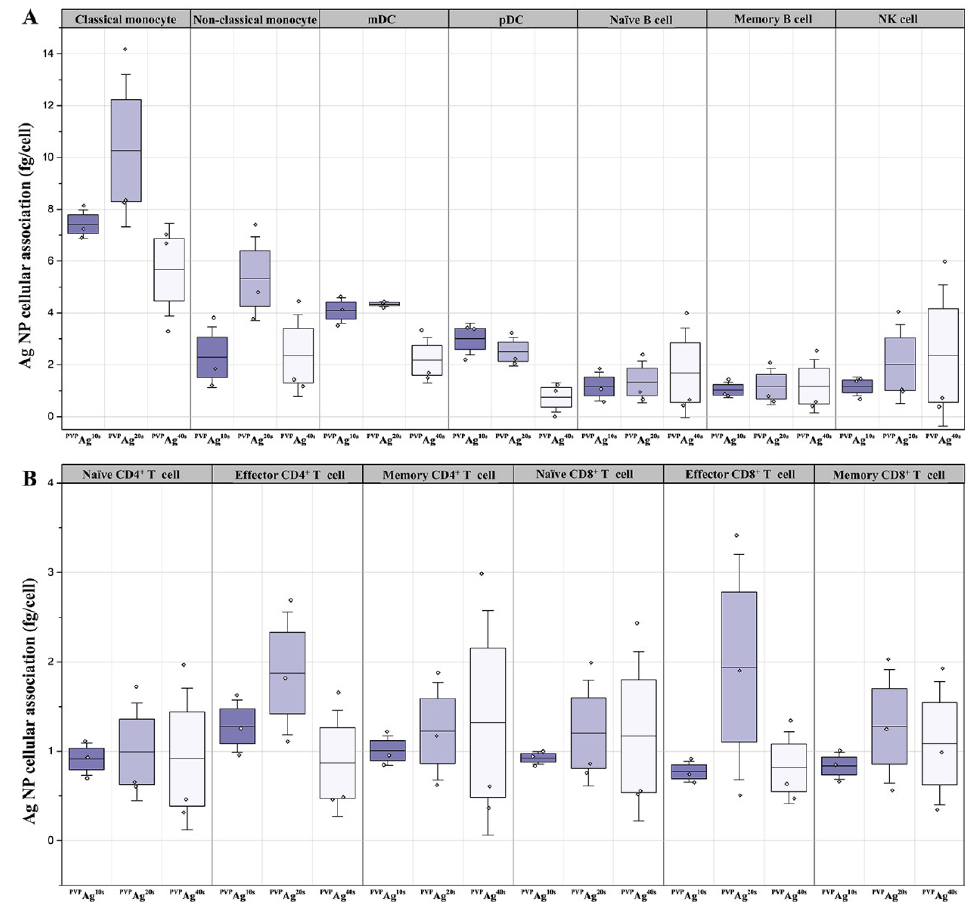
Figure 3. Cellular interaction of PVP Ag 10 , PVP Ag 20 , and PVP Ag 40 Ag NPS in hPBMC. ( A ) Comparison of the cellular association of non-T cells and ( B ) T-cell immune cell types are identified and manually gated population is shown in boxplots.